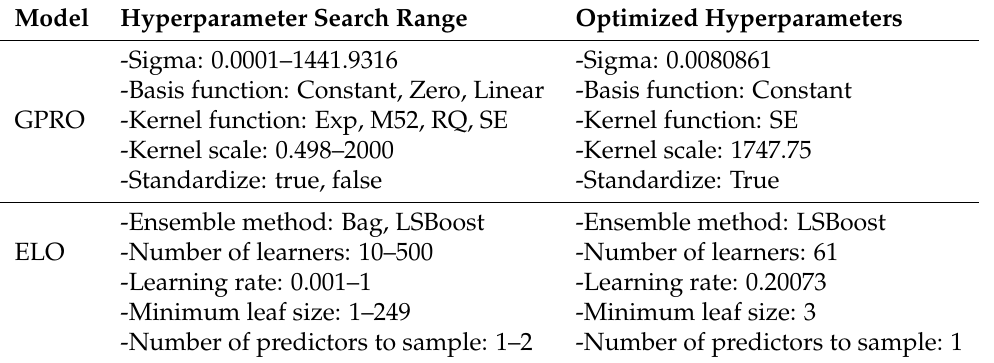
Table 1. Hyperparameters search range and optimized hyperparameters via the BO algorithm.